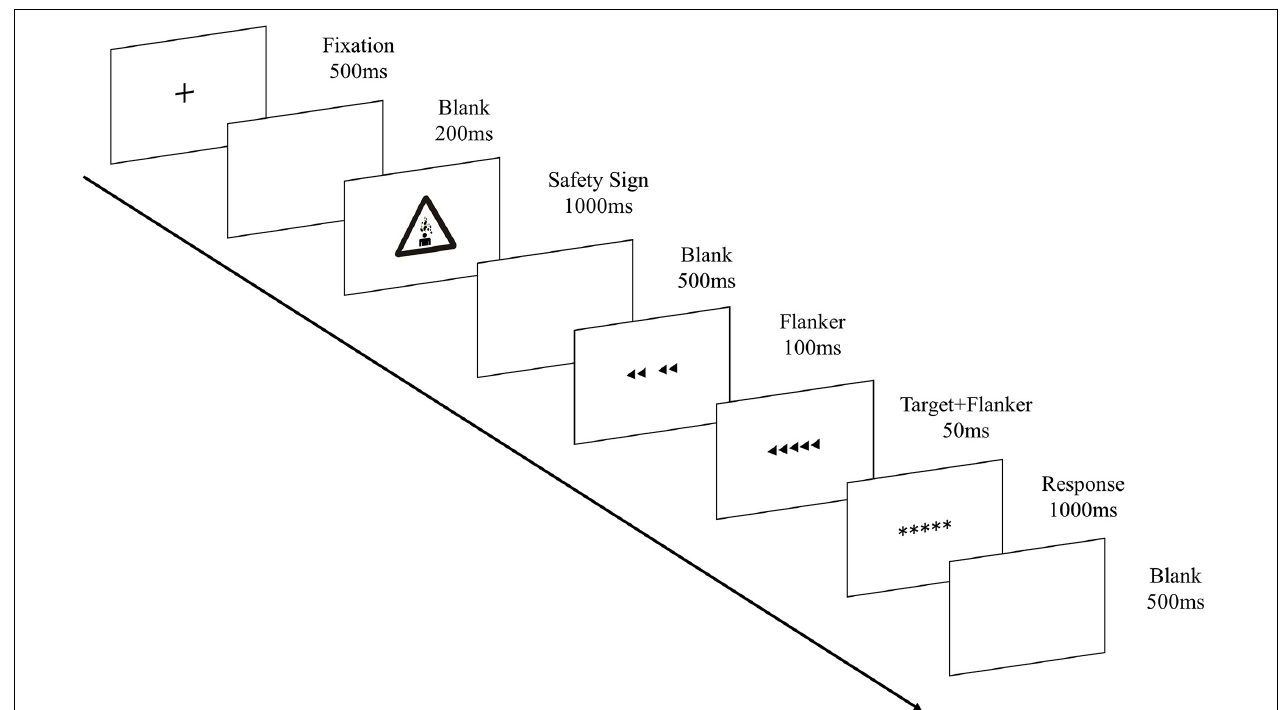
FIGURE 1 | Illustration of the experiment procedure in a trial.